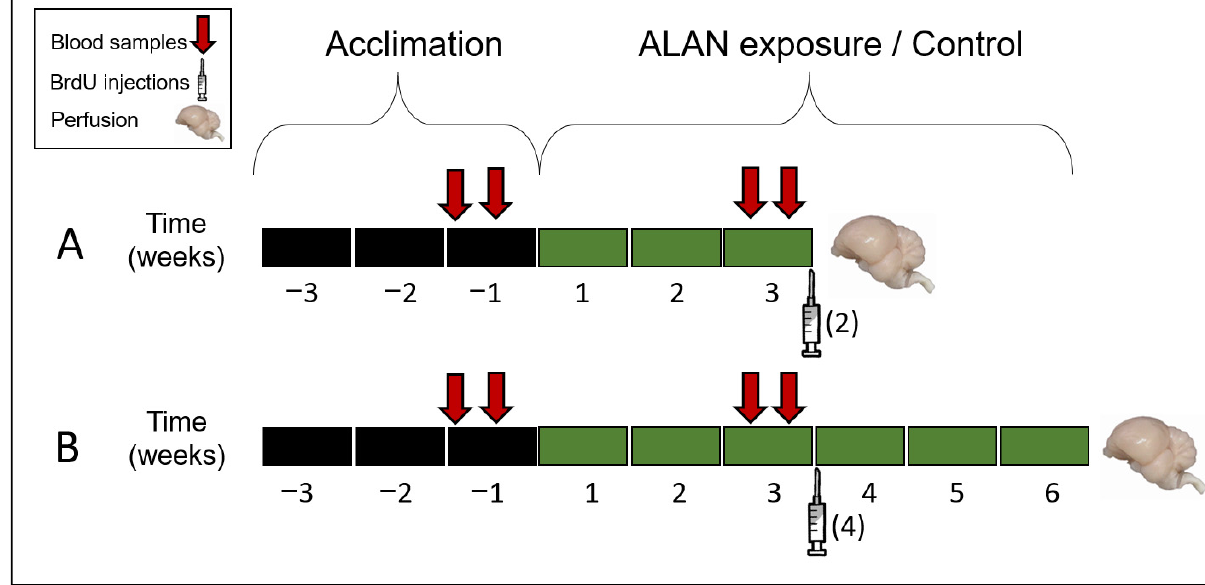
Figure 1. A schematic description of the experimental design. ( A ) Timeline of the cell proliferation experiment. ( B ) Timeline for the neuronal recruitment experiment. Red arrows indicate blood sampling; syringes indicate BrdU treatment times; and the numbers in brackets indicate the number of injections. See text for details.